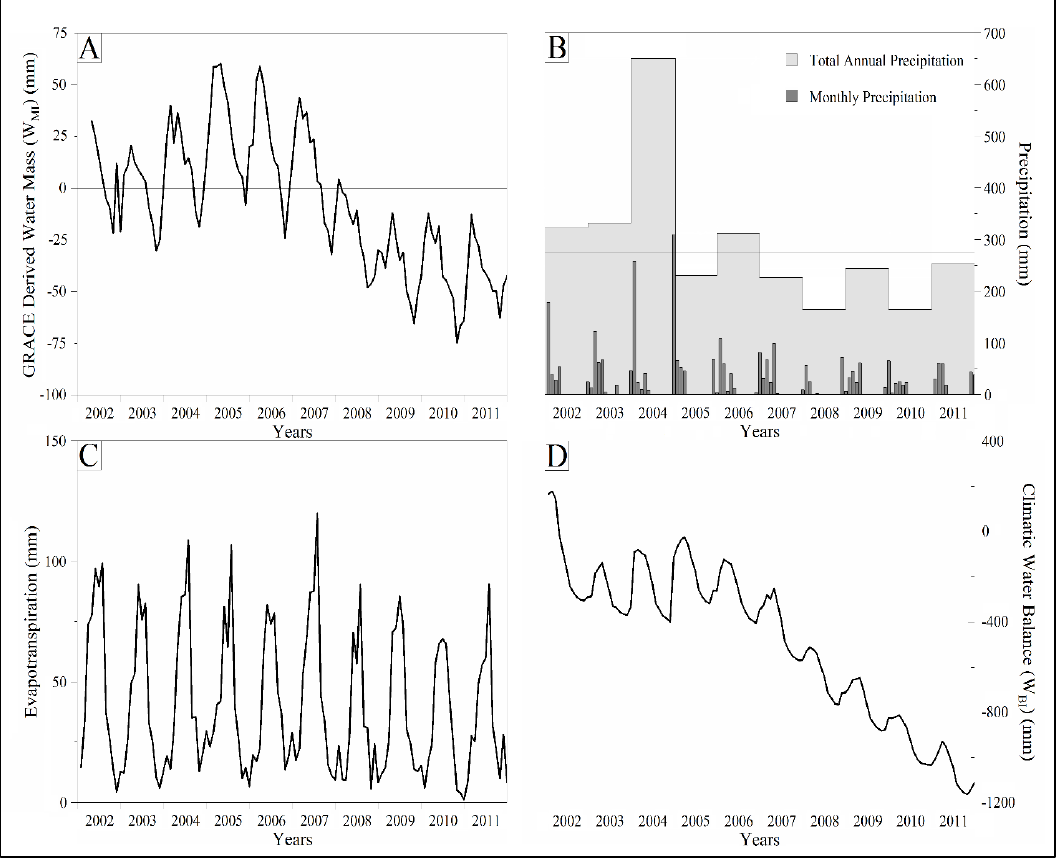
Figure 4. Changes in ( A ) GRACE—derived water mass (W MI ). Y axis: water mass changes (W MI ) in the catchment (mm). ( B ) Total annual and monthly net precipitation (where the vertical line indicates mean long—term precipitation (270 mm) in the catchment). Y axis: precipitation volume (mm). ( C ) Evapotranspiration rate in the catchment. Y axis: evapotranspiration volume (mm). ( D ) Climate water balance (W BI ). Y axis: (W BI ) volume change (mm), during the study period (January 2002—December 2011). The value of zero on the y—axis in A and D indicates no change in water mass.